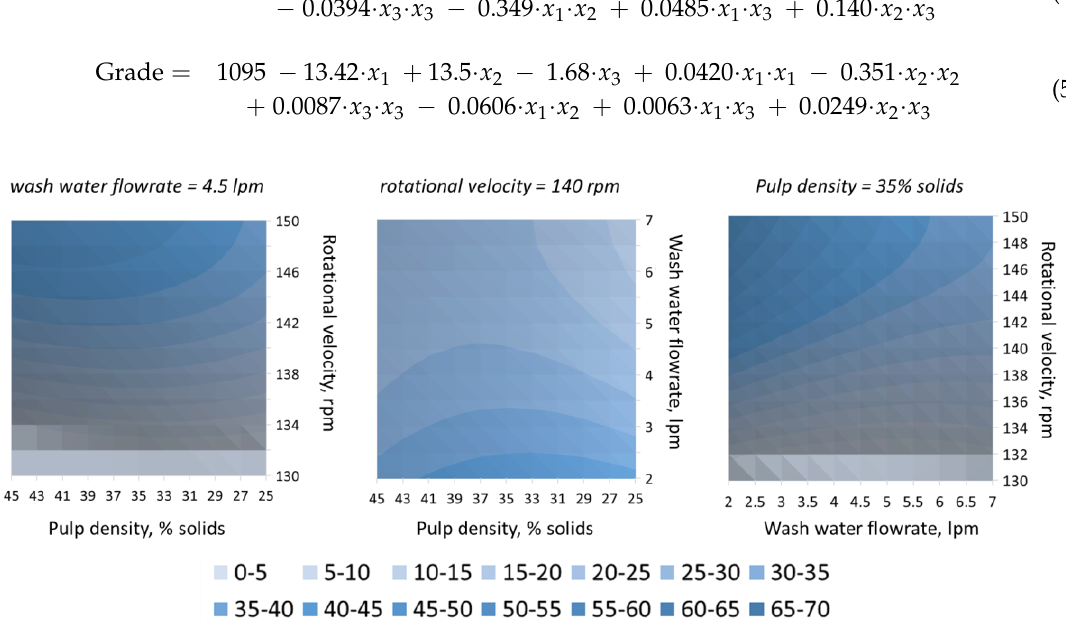
Figure 14. Response surface plots of WO 3 recovery to MGS concentrate stream at fixed variable positions.